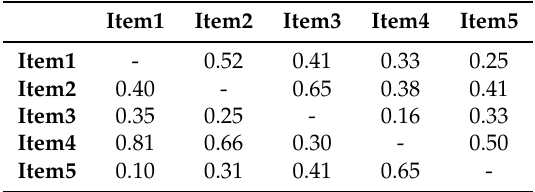
Table 4. A list of relative similarities of items through transitive